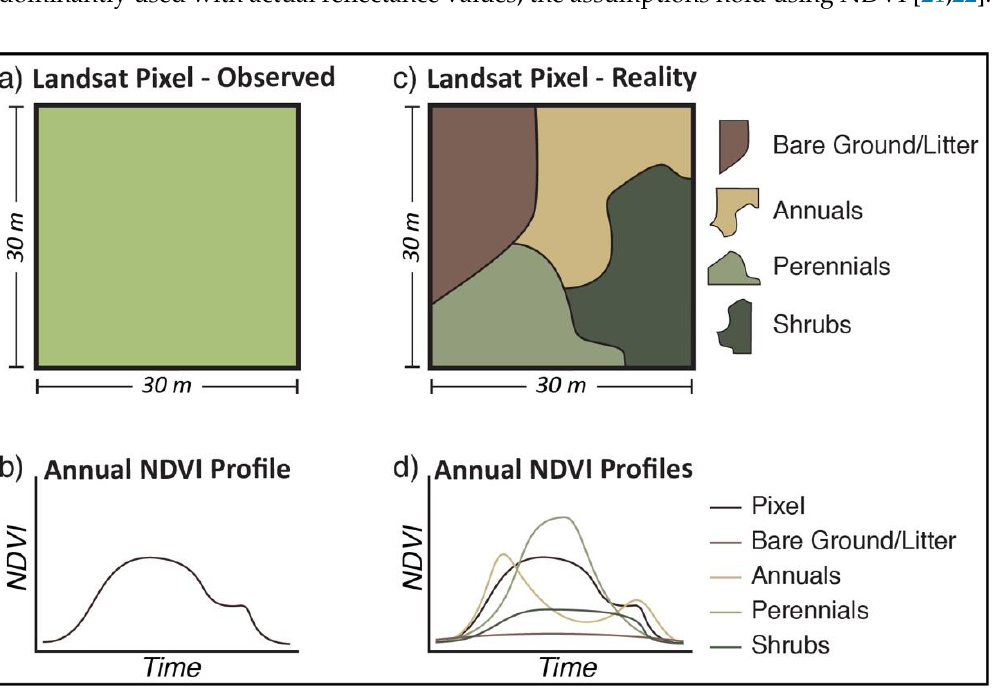
Figure 2. Conceptual differences between observed Landsat NDVI for a single pixel ( a ) and the subsequent phenological profile throughout a year ( b ), and a disaggregated pixel ( c ) with unique phenological profiles for each PFT ( d ). The pixel level NDVI for any point in time is a function of both the fractional area of the representative PFTs and their phenological state.